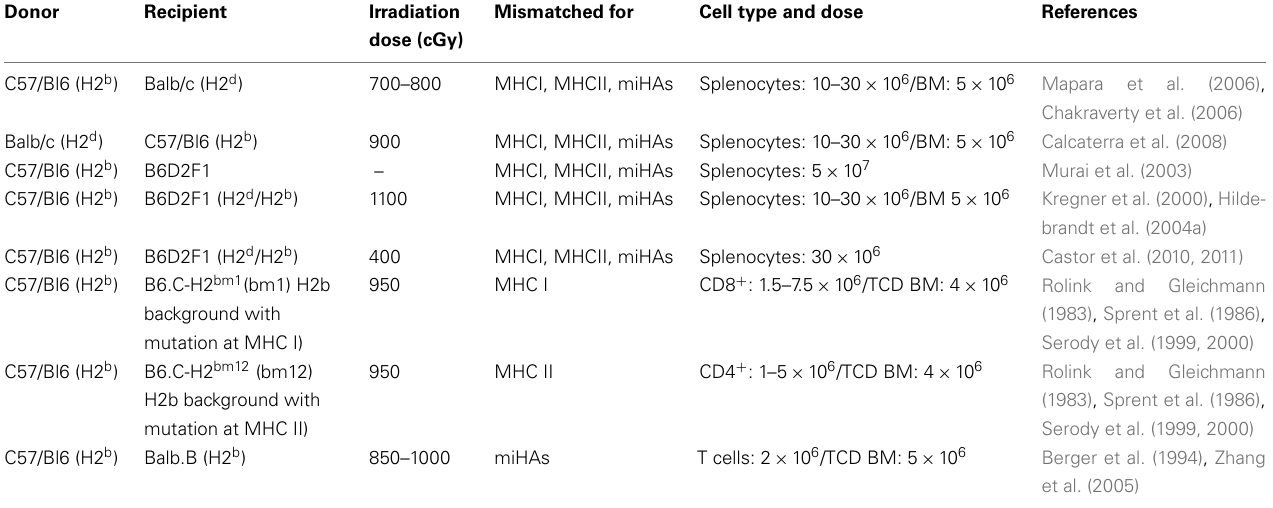
Table 1 | Mouse models of graft versus host